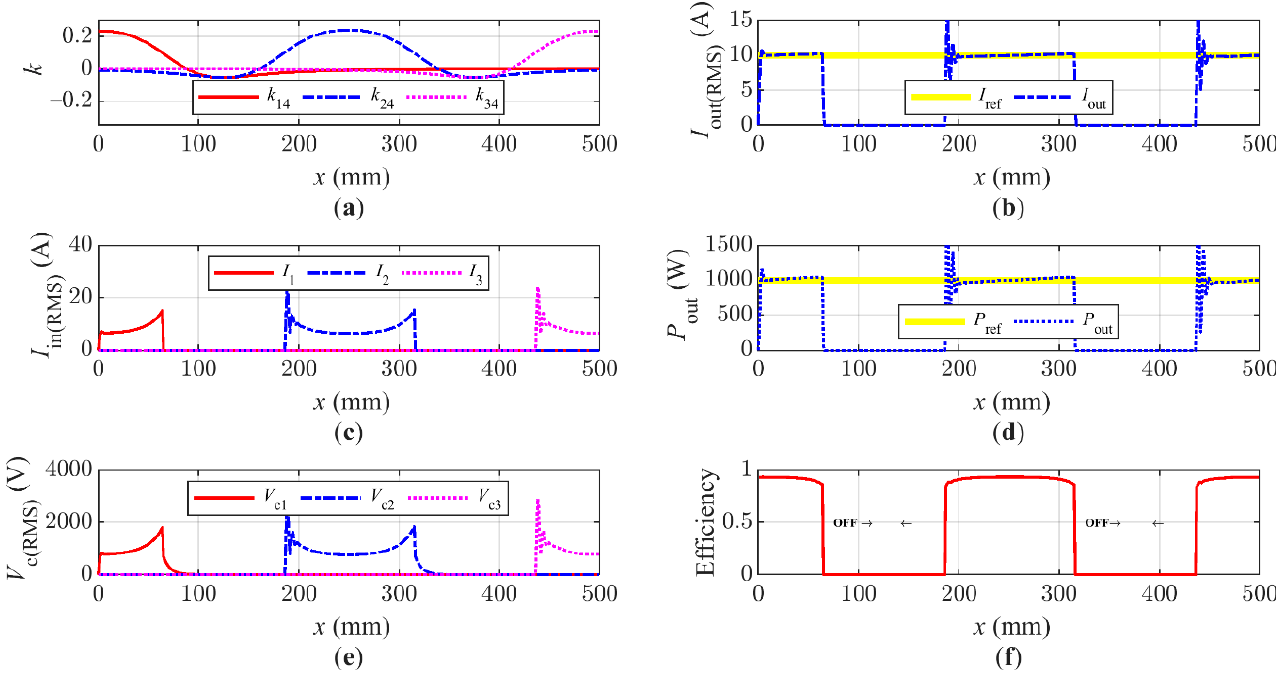
Figure 8. First solution: ( a ) coupling coefficients k 14 , k 24 and k 34 ; ( b ) output current I out(RMS) ; ( c ) input currents I 1(RMS) , I 2(RMS) and I 3(RMS) ; ( d ) output power P out(RMS) ; ( e ) voltages on the primary side capacitor V c 1(RMS) , V c 2(RMS) and V c 3(RMS) ; ( f ) system efficiency.